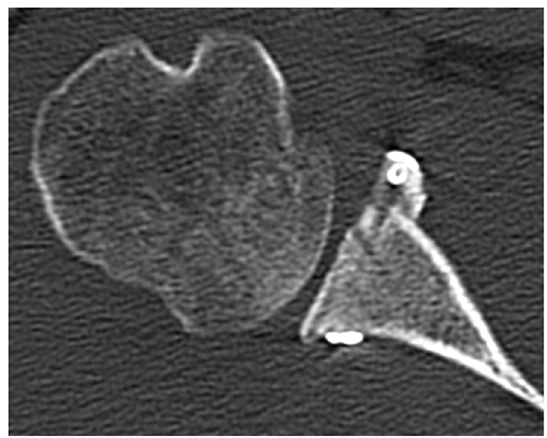
Fig. 4 Postoperative CT-scan of a patient with an off-track Hill-Sachs lesions who underwent an arthroscopic Eden-Hybinette procedure. Courtesy of Dr Miguel García Navlet, Hospital Asepeyo Coslada